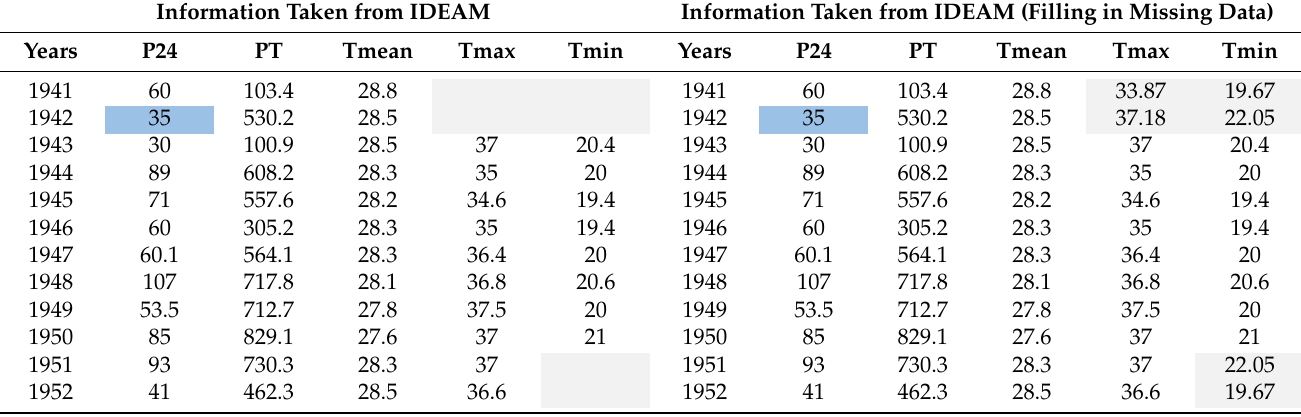
Table A1. Complete data of the